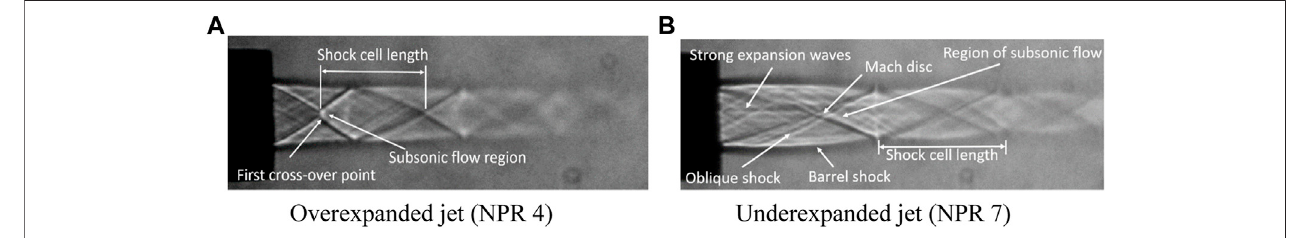
FIGURE 2 | Shadowgraphic views of the uncontrolled Mach 1.75 jet